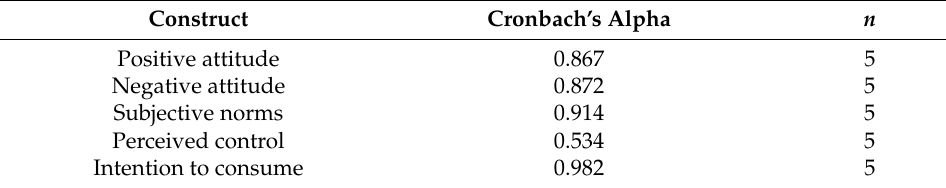
Table 1. Internal reliability statistics for TPB items in soft launch